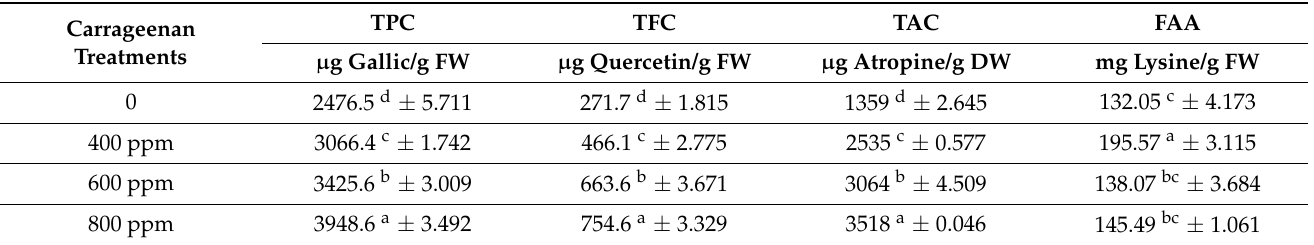
Table 1. Effect of carrageenan spraying on phytochemical constituents of Catharanthus roseus leaves expressed as equivalents of standard for each assay.